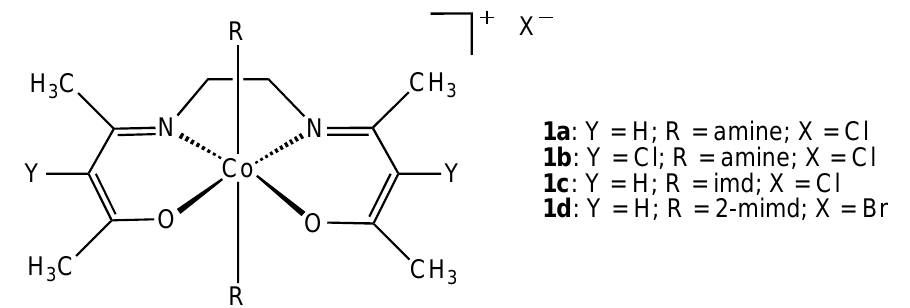
Figure 1. Structure of CTC-type cobalt(III) complexes (imd = imidazole, 2-mimd = 2-methylimidazole).